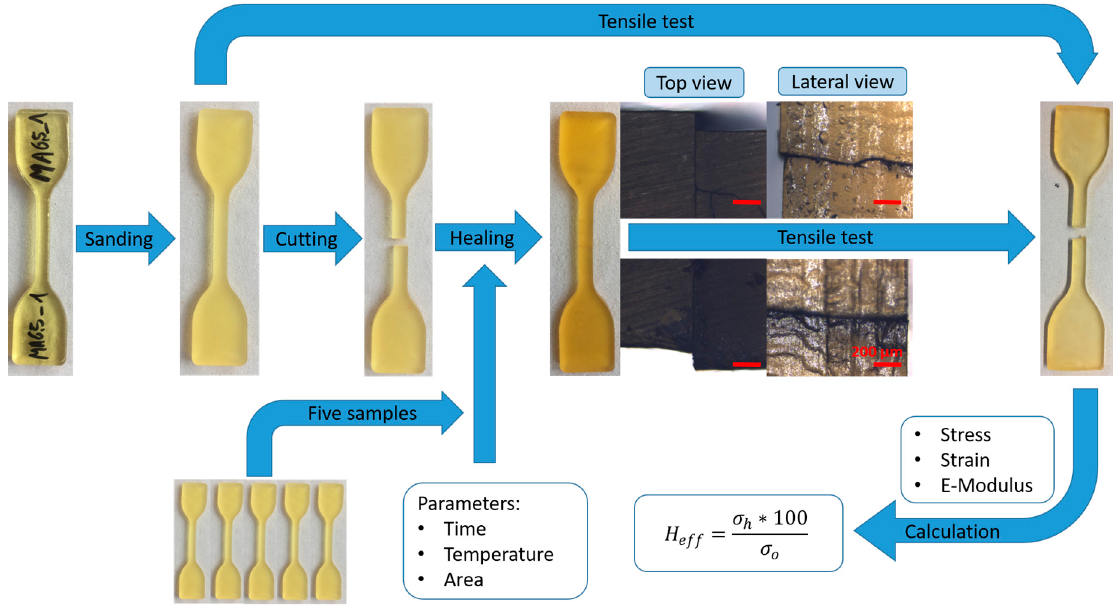
Figure 1. Schematic representations of the sample preparation and the measuring process. σ o is determined from the original samples and σ h from the healed sample. The healing efficiency is always considered regarding the different parameters.